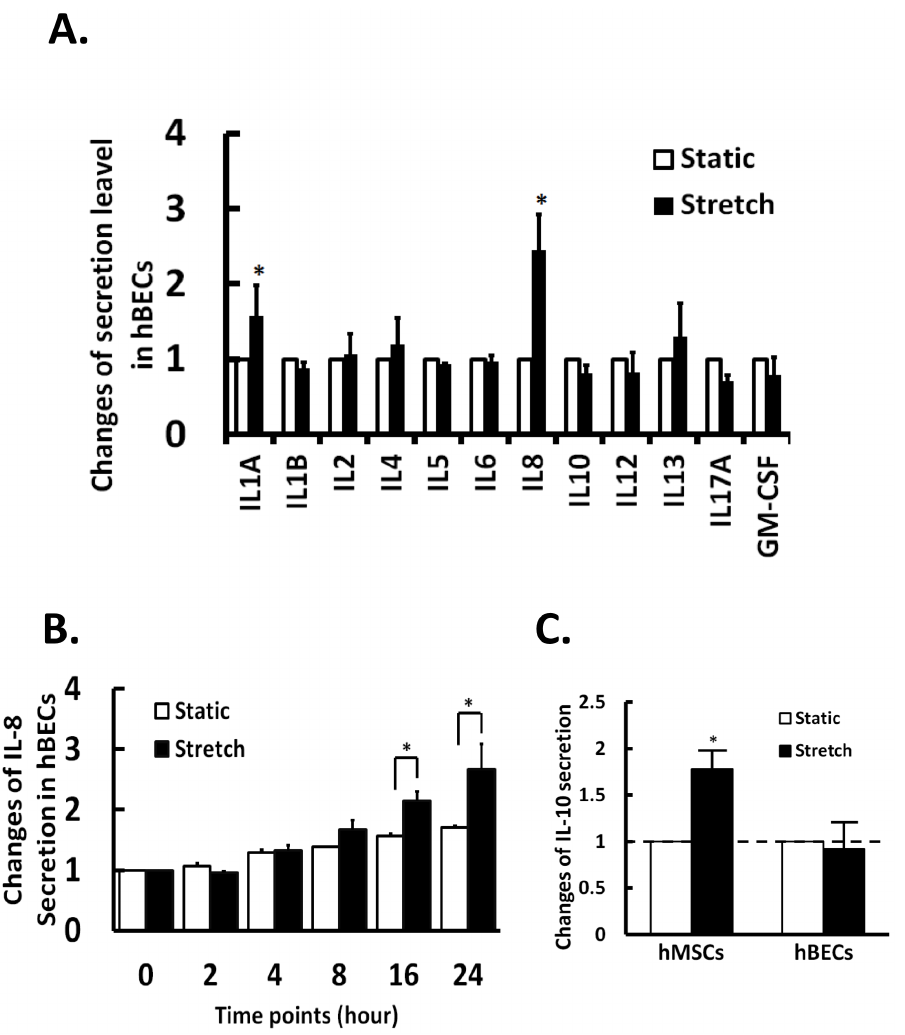
Figure 2. Secretion of inflammation-related cytokines by hBECs under hyperstretch. (A) Cytokine levels in conditioned medium of hBEC under hyperstretch were measured using a human cytokine Multi-Analyst ELISA array and normalized to the conditioned medium of static control. (B) Hyperstretch regulation of pro-inflammatory IL-8 secretion in hBECs over 24 hour period of time. (C) Hyperstretch regulation of anti-inflammatory cytokine IL-10 secretion by hBECs and hMSCs. The changes in secretion level are relative to static control. Data represent mean 6 s.e.m. *, P , 0.05; n=3.